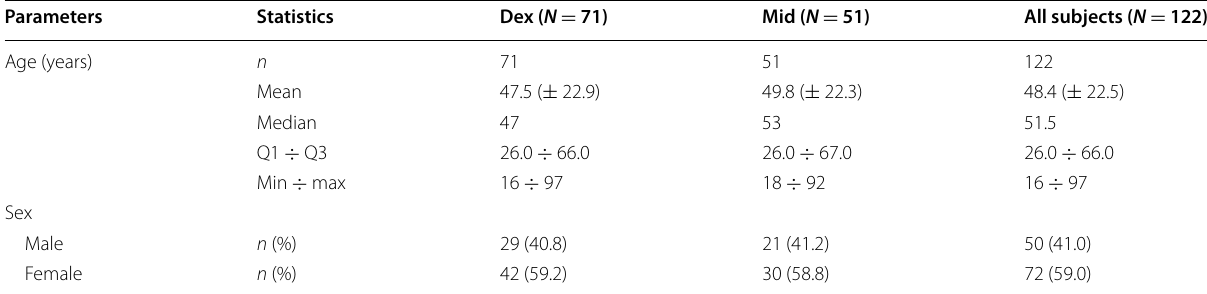
Table 1 Demographic parameters of the study population Parameters